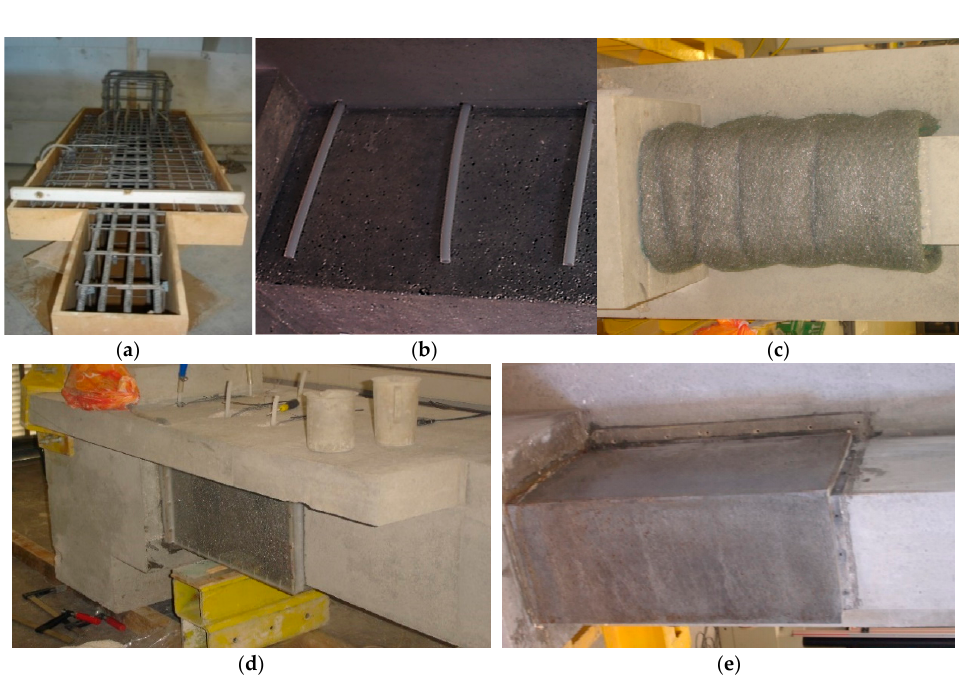
Figure 3. Specimen S3—UFRG jacketing and unbonded strand post-tensioning system. The jacketing with a grout reinforced with a unidirectional and continuous steel fibre mat is more efficient than the current reinforced concrete solutions since it allows for higher strengths for smaller thickness jackets. The UFRG exhibited a 66.0 MPa compres- sive strength and 12.3 MPa tensile strength.